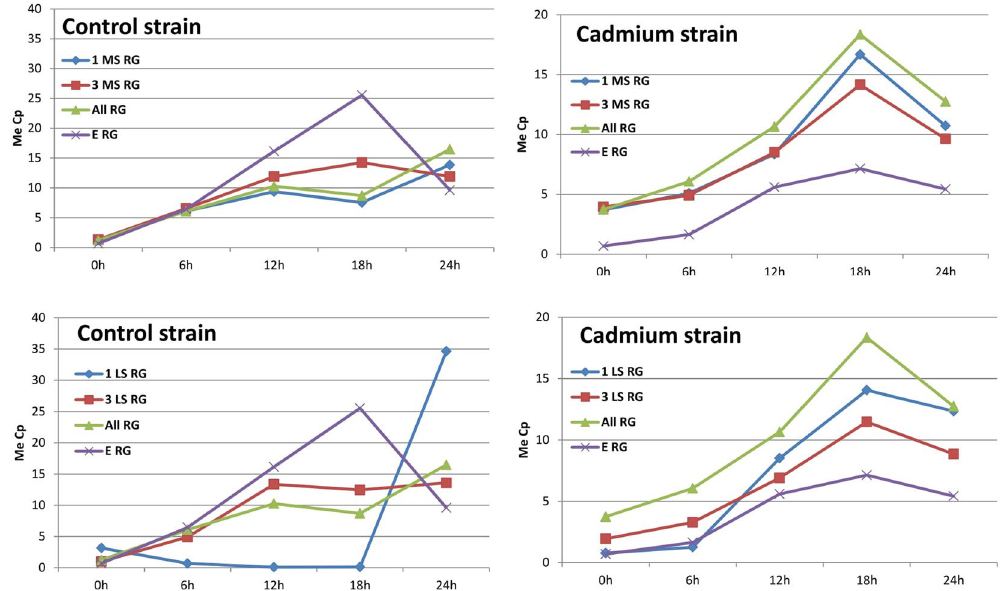
Figure 7. The daily pattern of the vitellogenin gene expression in two breeding strains of Spodoptera exigua (control and cadmium) by using: three most stable (3 MS RG), three least stable internal reference genes (3 LS RG), one most stable internal reference gene (1 MS RG), one least stable internal reference gene (1 LS RG) and external reference gene (E RG) and all reference genes (All RG) in qPCR analysis (according to the general ranking shown in the Table 1). Abbreviations: 0 h, 6 h, 12 h, 18 h, 24 h - time after